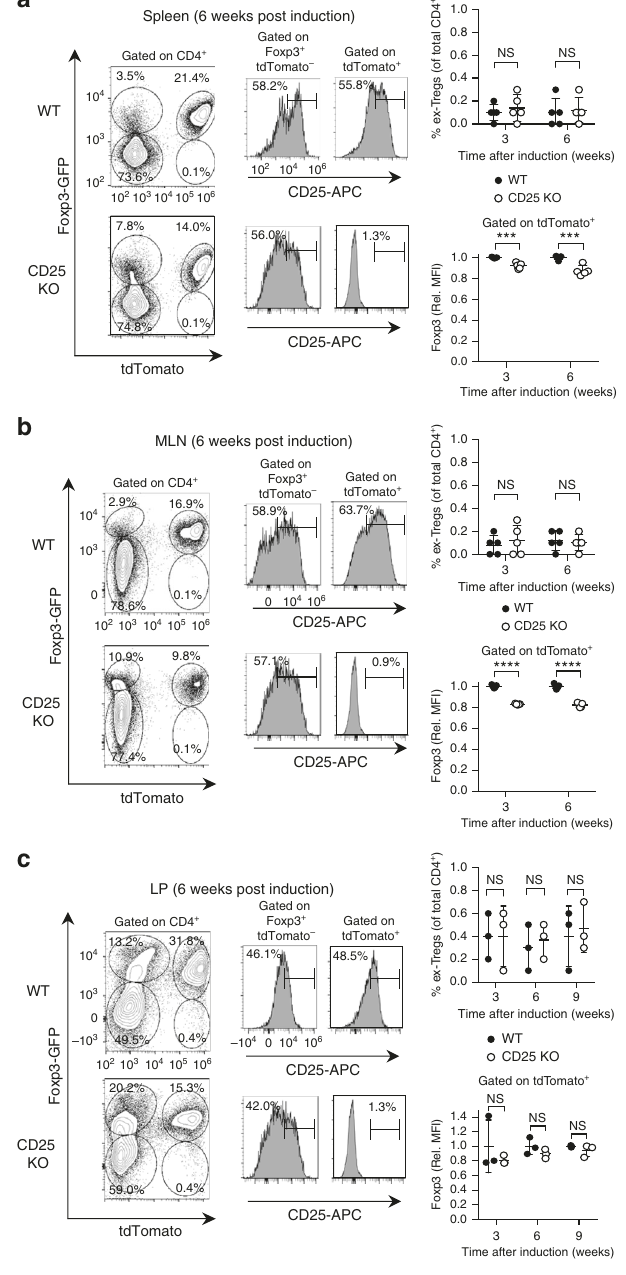
Fig. 7 CD25 KO peripheral Tregs show only a modest decline in